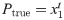
Behavioral results, quantitative analysis across participants (n = 12).To analyze the relation between these behavioral data with the predictions made by models, we first looked at the variability of all these measures conditioned on the predicted probability and gathered over 5 equal partitions of the [0, 1] probability segment. For the 12 participants, we collected an estimate of (A) the amplitude of anticipatory pursuit (aSPEM) and (B) the bet score value. As a regressor, we have used the true probability (Ptrue=x1t, blue color), and the probability bias estimates obtained with a leaky integrator (Pleaky, orange color) and by the BBCP model (PBBCP, green color). We display these functional relations using an error-bar plot showing the median with .25 and .75 quantiles over the 5 partitions. This shows a monotonous dependency for both behavioral measures with respect to the probability, close to a linear regression, but with different strengths. Second, we summarize in insets quantitative measures of the strength of this dependence for each participant individually, by computing the squared Pearson correlation coefficient r2 and the mutual information (MI). Dots correspond to these measures for each individual observer, while the bar gives the median value over the population. This confirms quantitatively that for both experimental measures, there is a strong statistical dependency between the behavioral results and the prediction of the BBCP model, but also that this dependency is significantly stronger than that obtained with the true probability and with the estimates obtained with the leaky integrator (stars denote significative differences, see text for details).